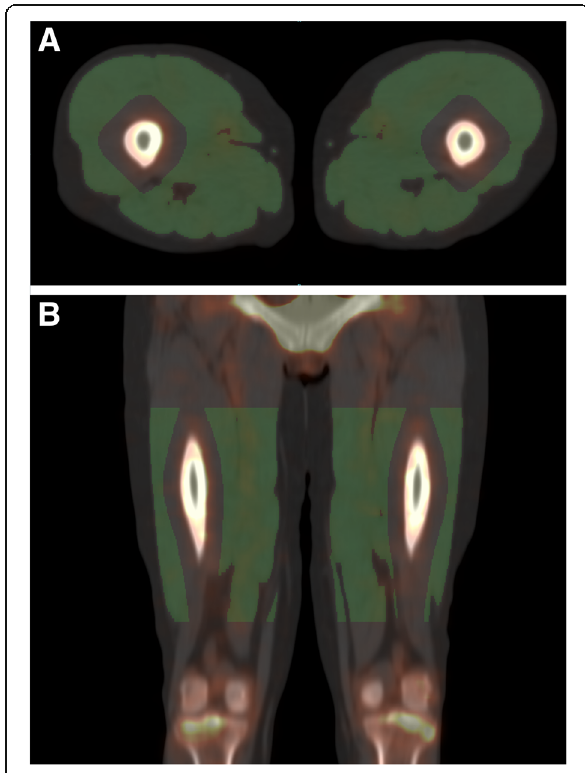
Fig. 1 Volume of interest (VOI) encompassing bilateral thigh muscles. a Transaxial slice. b Coronal